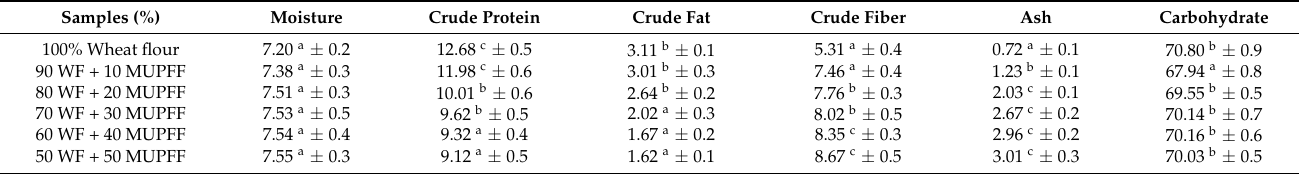
Table 1. Proximate composition of composite flour from wheat flour and unripe pawpaw fruit flour (%)